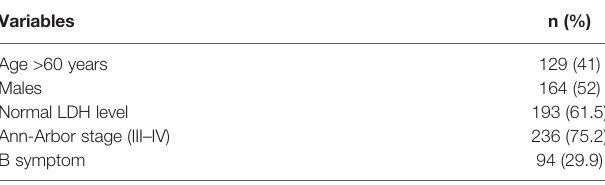
TABLE 1 | Clinical characteristics of patients at diagnosis (n = 314).